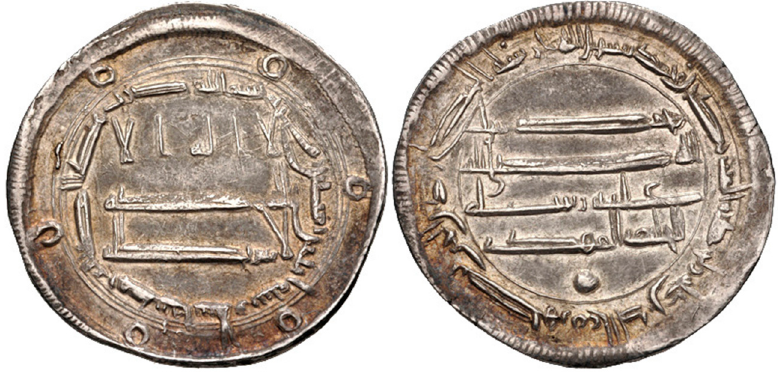
Figure 1. Abb ā sid dirham. Mint: al-Ma ḥ d ī , AH 162 (778/9 CE). Mad ī nat al-Sal ā m (Baghdad). ©Clas- Figure 1. Abb¯asid dirham. Mint: al-Mah.d¯ı, AH 162 (778/9 CE). Mad¯ınat al-Sal¯am